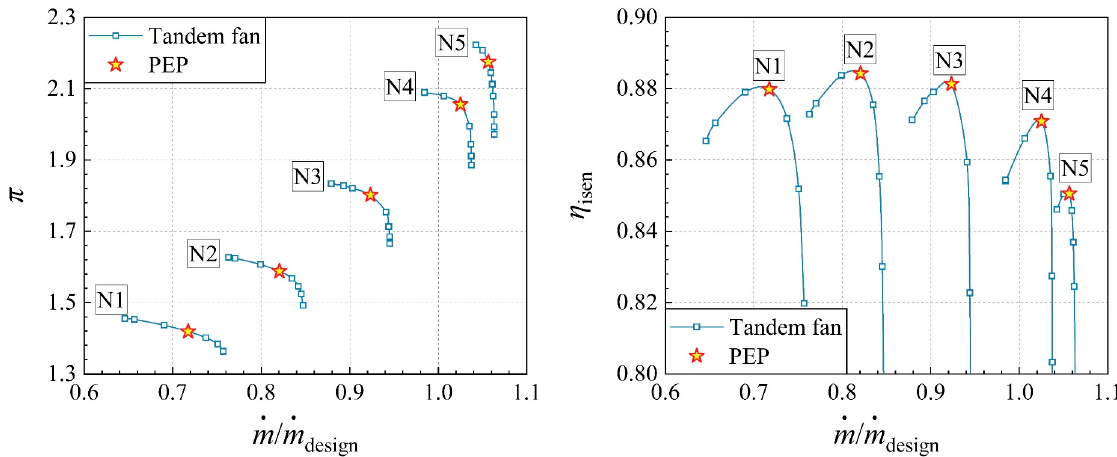
Figure 7. Aerodynamic performance of the high-throughflow fan stage at different rotating speeds.